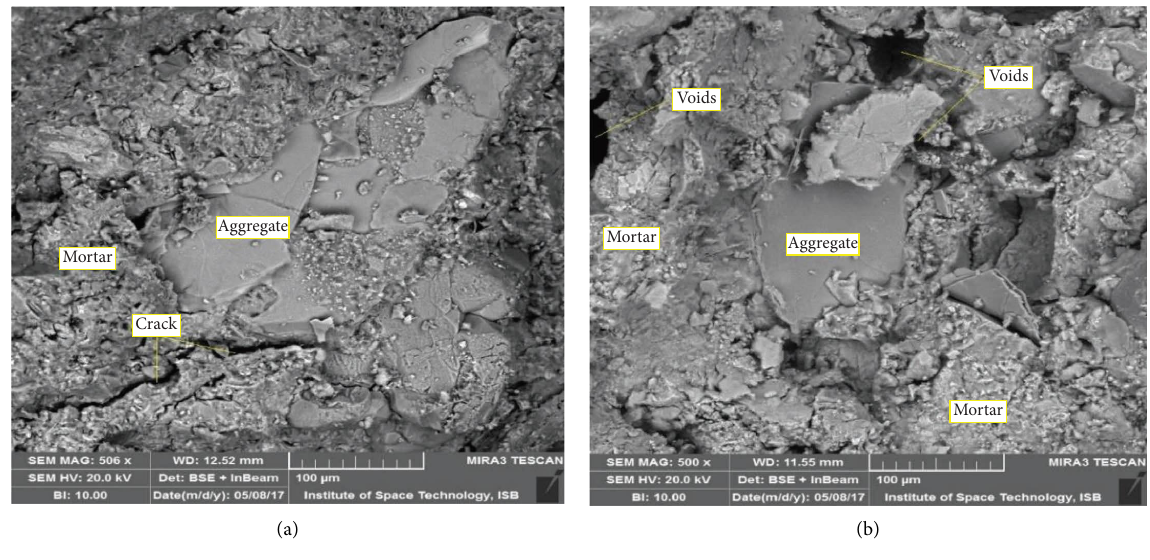
Figure 11: Interfacial morphology of NCASCC and